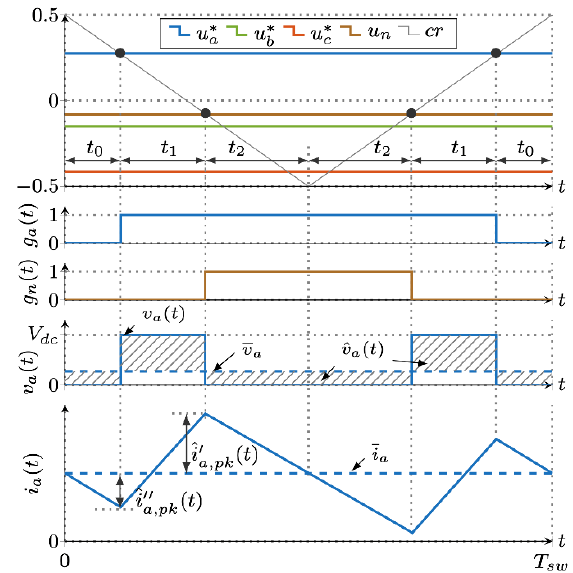
Figure 5. Current ripple waveform (phase a ) (bottom) and voltage pulse disposition (phase a ) (middle) generated by a generic modulation strategy in one switching period (top).